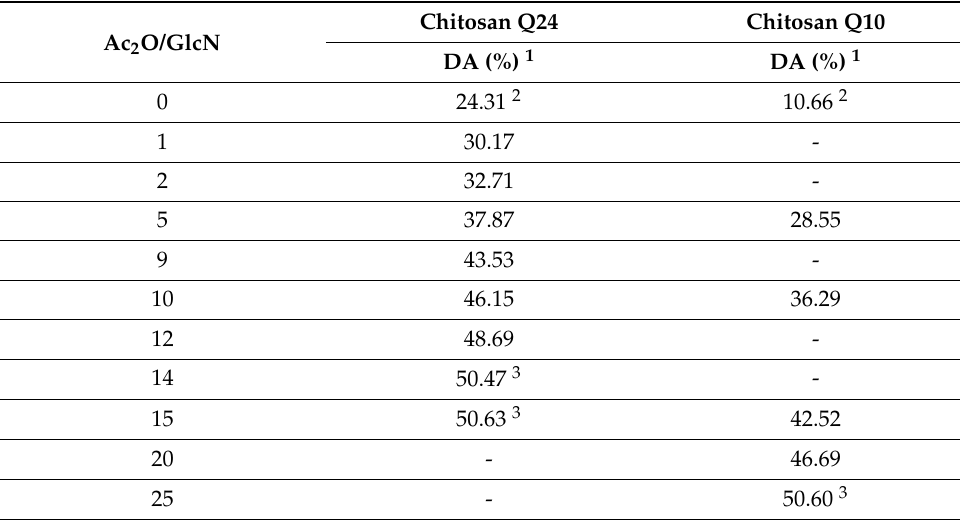
Table 3. DA of acetylated chitosans with different Ac 2 O/GlcN molar ratios. Chitosan Q24 Chitosan Q10 Ac 2 O/GlcN